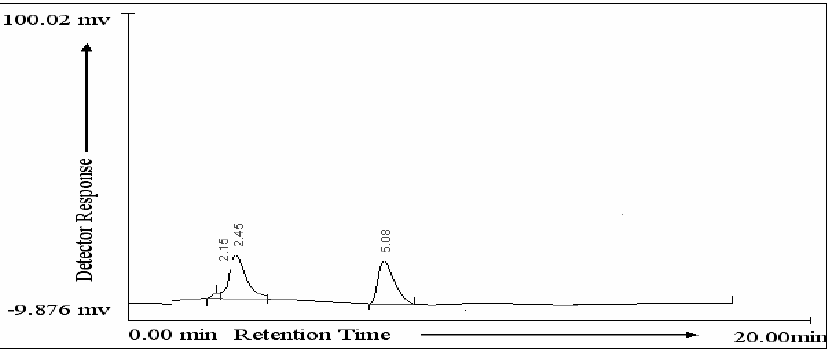
Figure 4. Chromatogram showing degradation in 0.1 M HCl